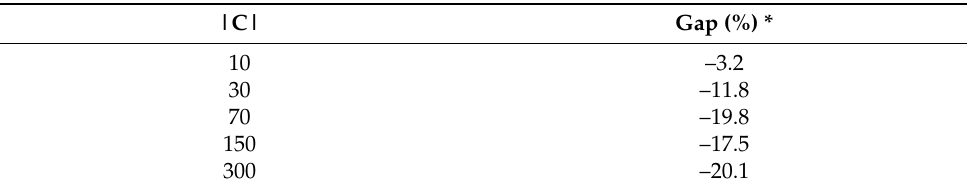
Table 4. DRLV1 Solution Quality. * Results presented as percentage gap when compared to UPPERBOUND. Result = 100 ∗ AVG((DRLV1 –